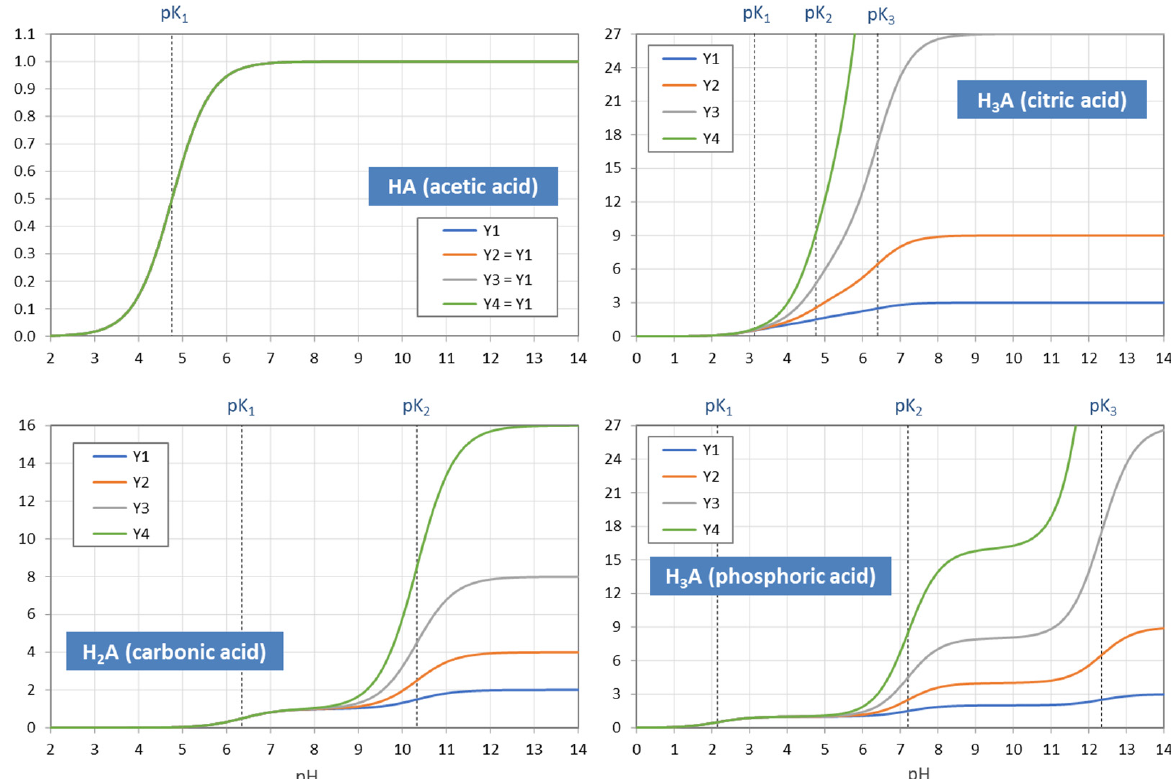
Figure 6. pH dependence of the moments Y 1 to Y 4 for four acids. In the case of monoprotic acids (top-left diagram), all Y L are equal, i.e., the four curves cover each other.